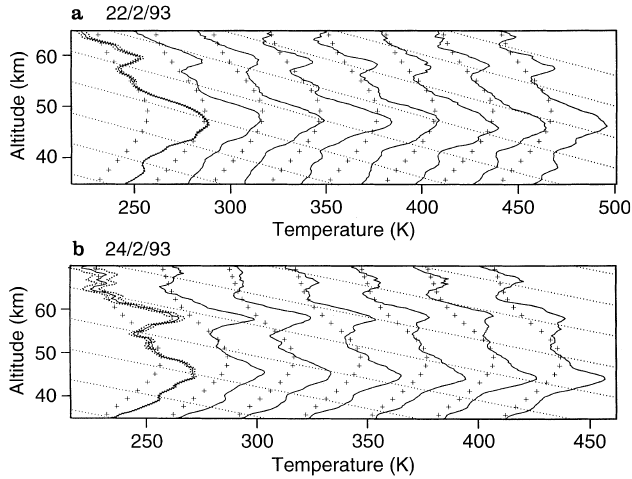
Fig. 2a, b. The individual temperature profiles derived from 20-min observations on the nights of a 22 February 1993 and b 24 February 1993, successive profiles being o(cid:128)set by 40 K. The estimated uncertainties for the first profile for each night are shown. The dotted lines have slopes corresponding to the dry adiabatic lapse rate